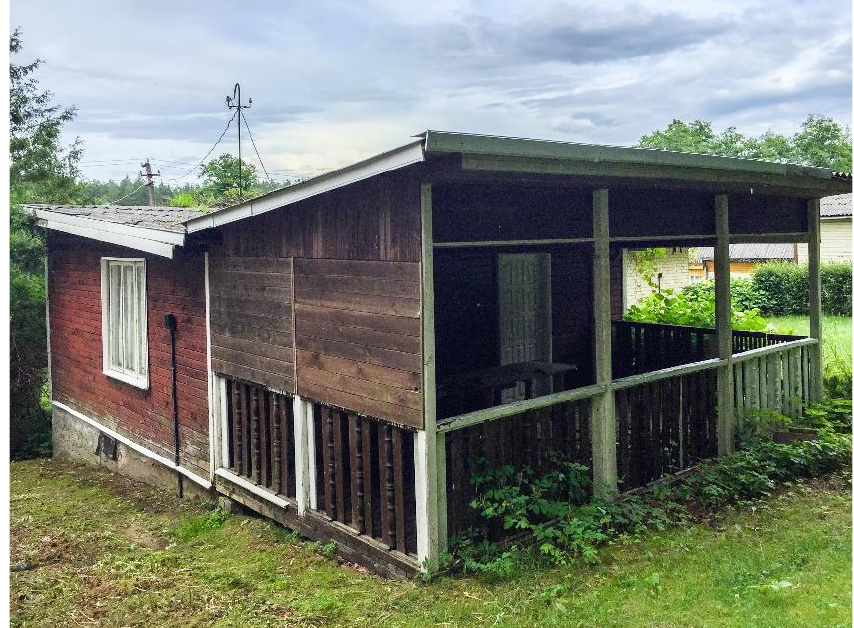
Figure 12. Garden house in Gvazdikų st., Vilnius. Photo by A. Gabrėnas .